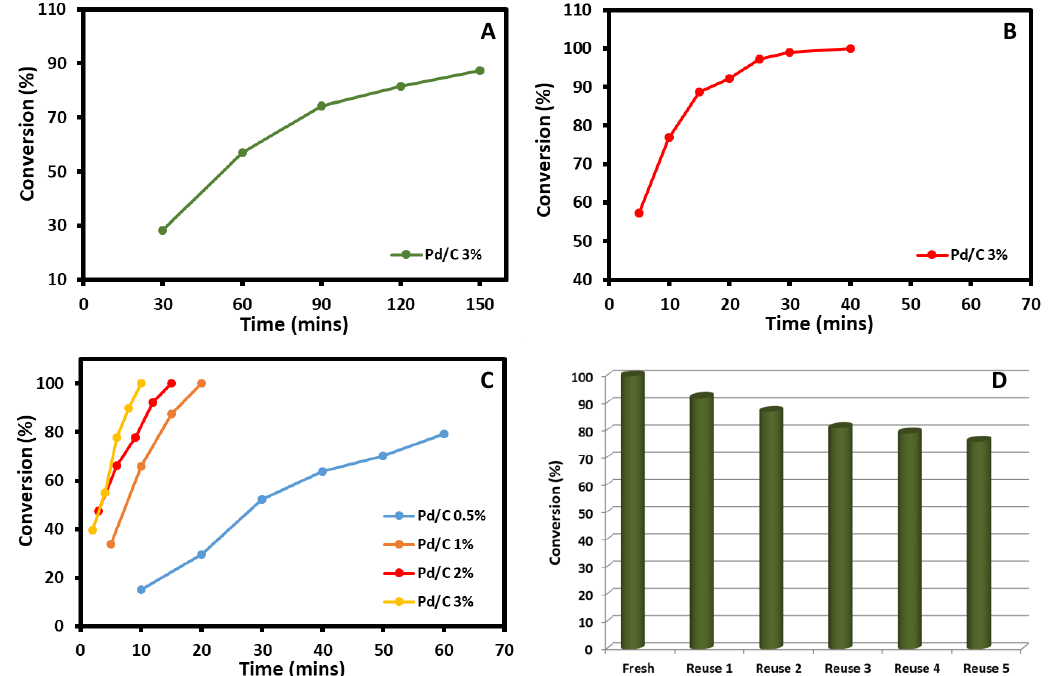
Figure 6. Chemical kinetics plot of the Suzuki reaction using a Pd/C catalyst for various substrates: ( A ) chlorobenzene, ( B ) bromobenzene and ( C ) iodobenzene. ( D ) Recyclability studies for the Pd/C 3% catalyst, using iodobenzene as the main reactant.